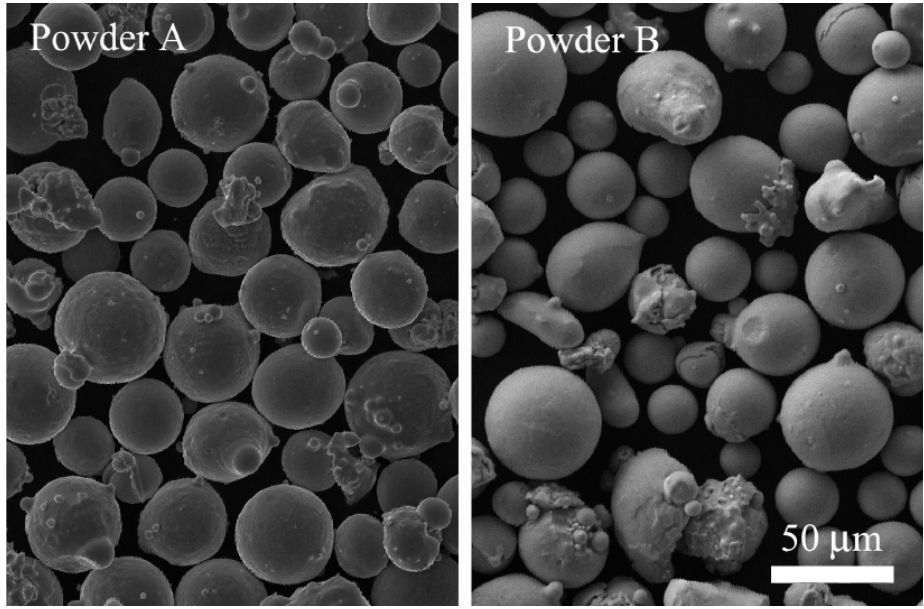
Figure 1. SEM micrographs of the powders A and B.